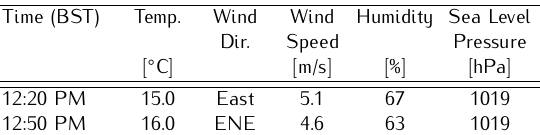
Table 3. Weather station Glasgow (EGPF), records 12:20 PM and 12:50 PM on June 25 2006. Time (BST) Temp.